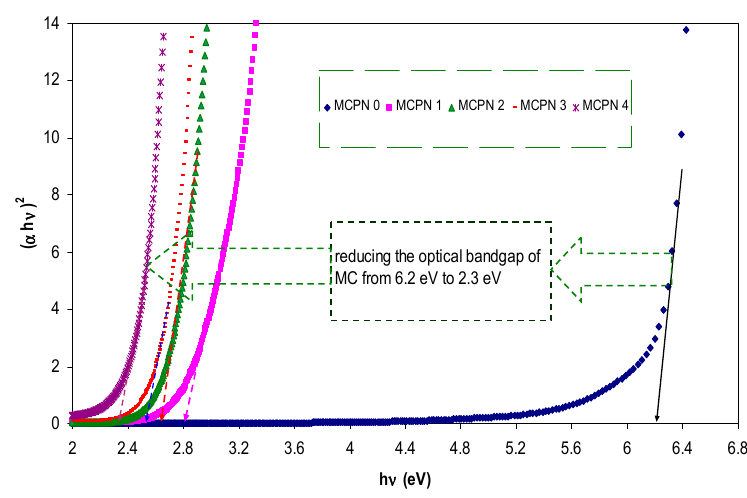
Figure 6. Plot of ( α h υ ) 2 versus photon energy (h υ ) for pure MC and doped MC films.